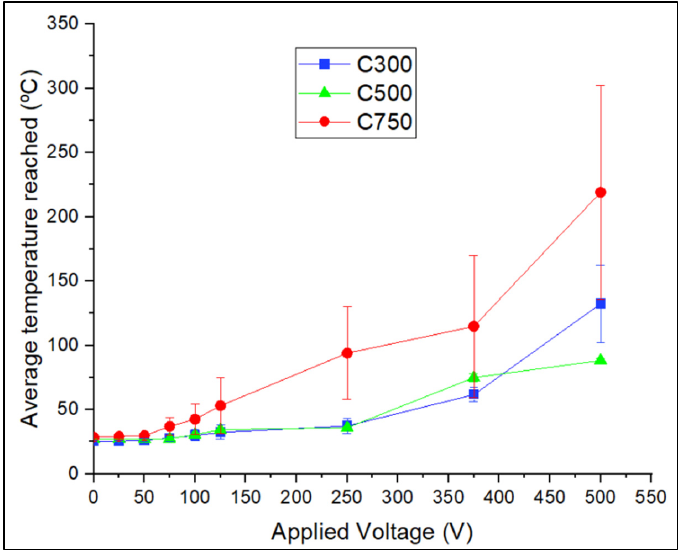
Figure 9. Average temperature reached as a function of the applied voltage for GNP/epoxy composites, applying 30 min of sonication.